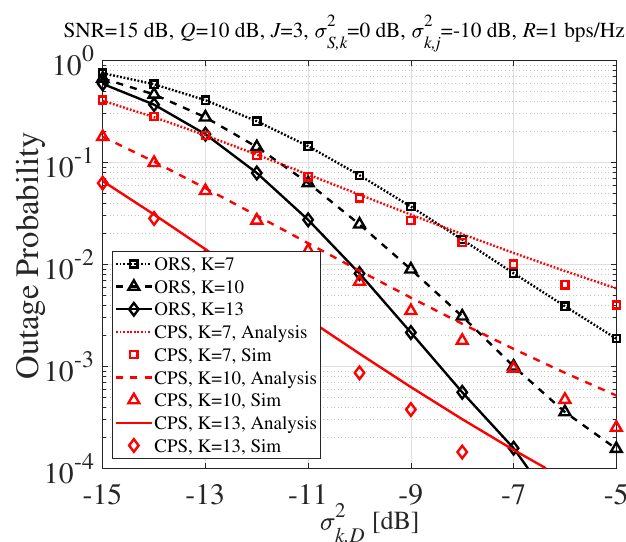
Figure 5. Outage probability according to σ 2